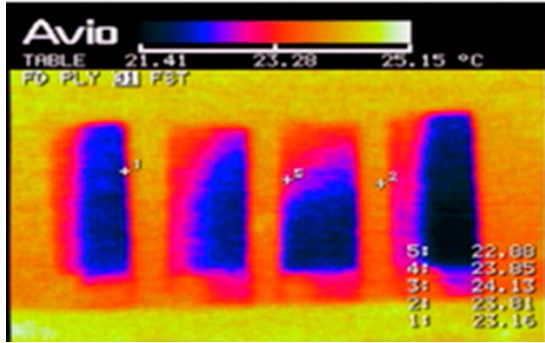
Figure 10. IRT investigation of a salt solution capillary rise test in brick-plaster-coating systems.